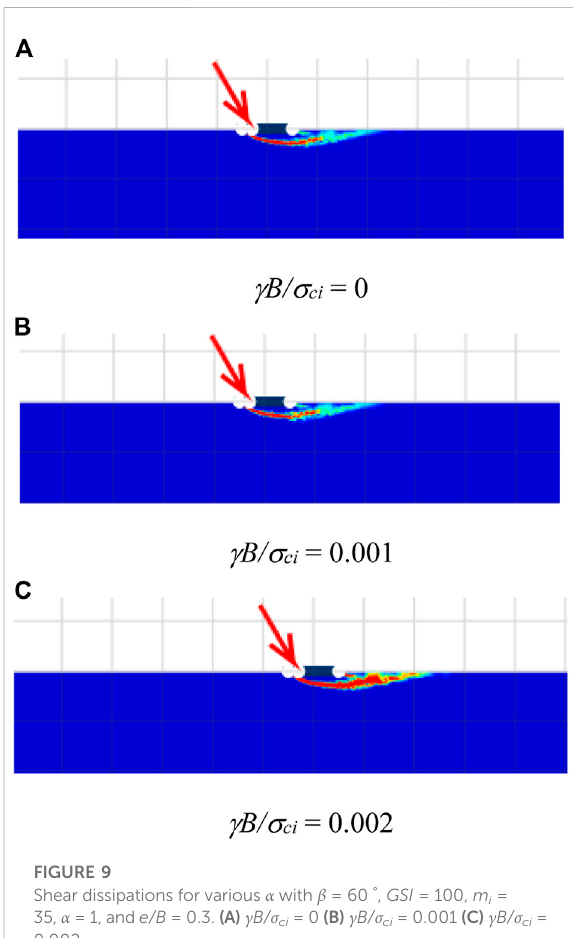
FIGURE 9 Shear dissipations for various α with β = 60 ° , GSI = 100, m i = 35, α = 1, and e/B = 0.3. (A) γ B/ σ ci = 0 (B) γ B/ σ ci = 0.001 (C) γ B/ σ ci = 0.002.